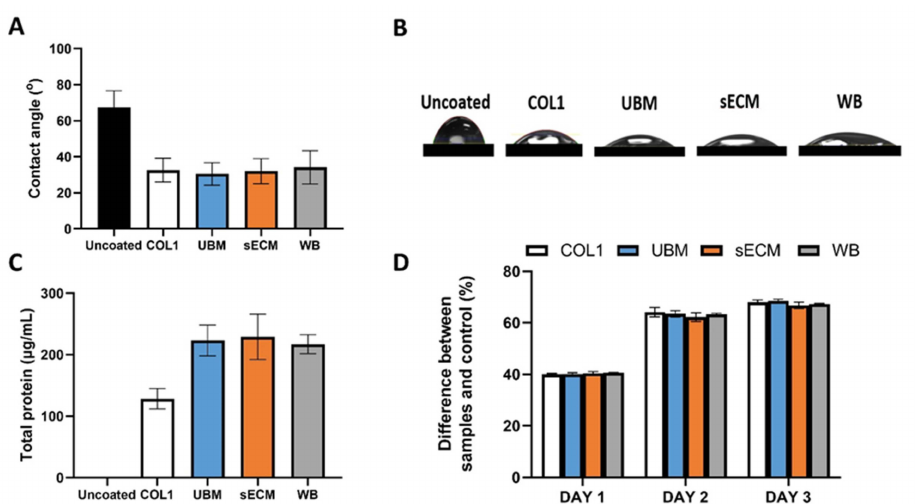
Figure 6. Coating confirmation by contact angel measurement ( A , B ) and total protein adsorption by BCA assay ( n = 3) ( C ). ( D ) C2C12 viability on different coated surfaces studied by Alamar blue assay ( n =